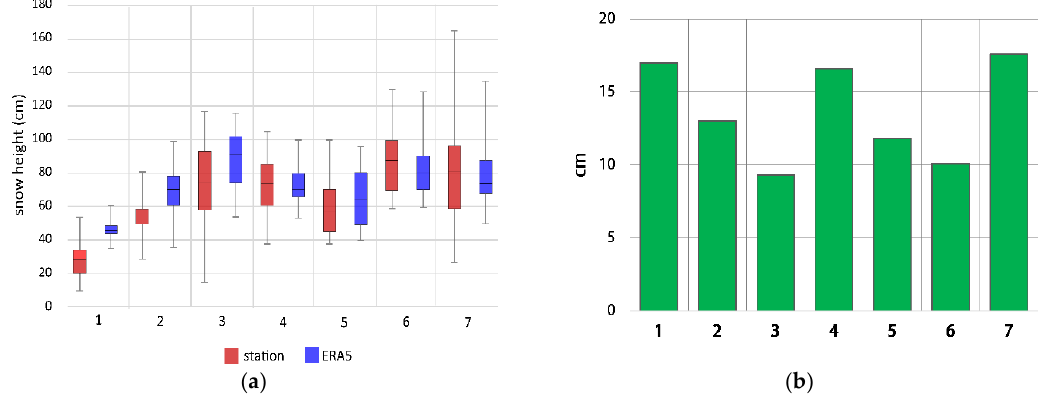
Figure 11. Whisker-box plot of maximum snow height at the end of cold season for seven stations ( red ) and the nearest grid points of ERA5 reanalysis ( blue ) ( a ) and RMSE for maximum snow height for seven stations and the nearest grid points of ERA5 reanalysis ( b ). Boxes in ( a ) indicate the lower and upper quartile. Horizontal line in each box represents the median t2m air temperature. Vertical lines extending from each box represent the minimum and maximum temperature recorded for that station.